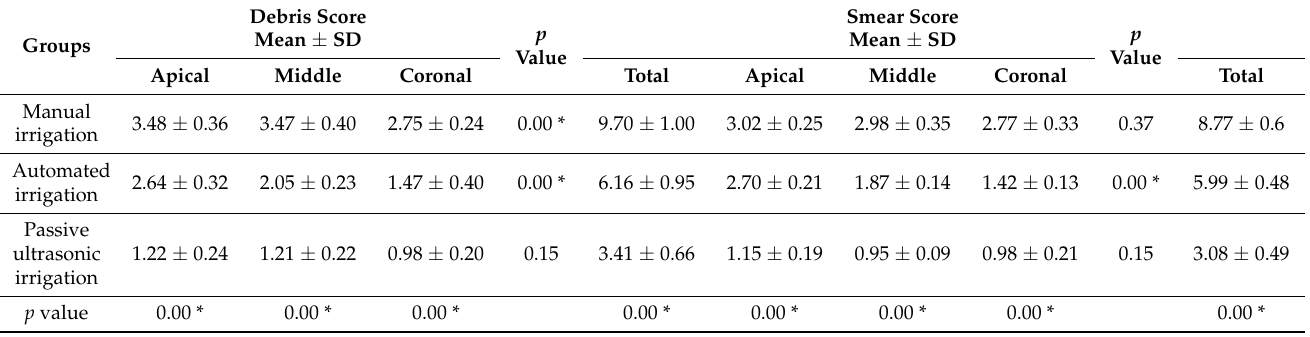
Table 1. Mean distribution of debris and smear scores among different irrigation modes.